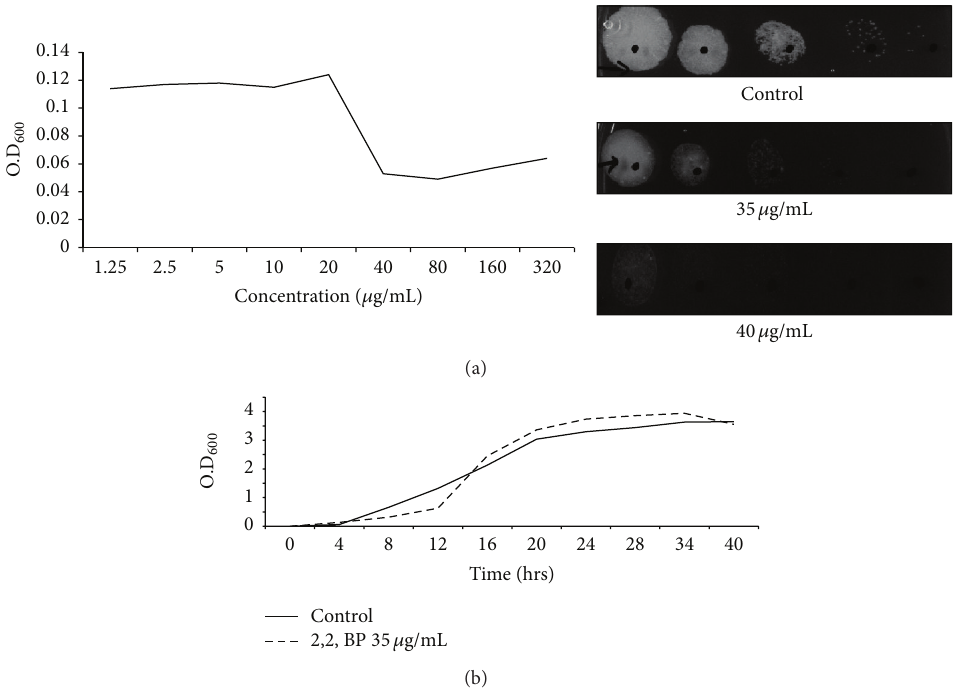
Figure 1: Assessment of mycobacterial growth in response to iron deprivation. (a) Drug susceptibility assays against M. smegmatis in the presence of 2,2, BP. Left panel shows broth microdilution assay to determine the MIC 80 of M. smegmatis in the presence of 2,2, BP. The minimum drug concentration that inhibits growth by 80% relative to the drug-free growth control is indicated as MIC 80 . Right panel shows spot assay of M. smegmatis in the absence (control) and the presence of subinhibitory concentration of 2,2, BP (35 𝜇 g/mL). (b) Growth curve of M. smegmatis in the presence of 35 𝜇 g/mL 2,2,